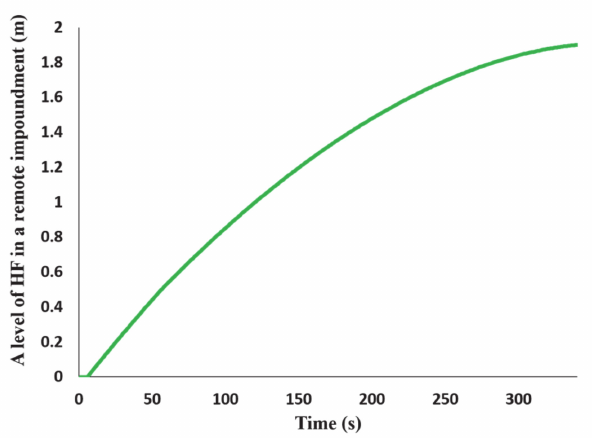
Figure 5. The level of the HF in the remote impoundment. This result shows that Pump 2 can prevent the overflow of the remote impoundment.